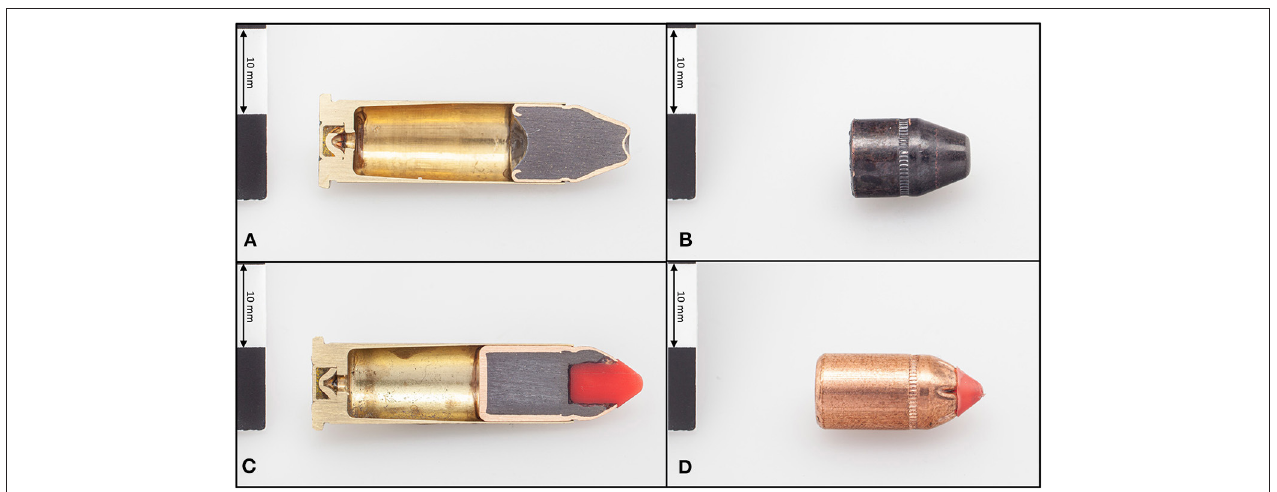
FIGURE 2 | Specimens of a full metal jacket .38 SPL FMJ-TC cartridge (A) and projectile (B) with a truncated cone and a .357 MAG FTX ® cartridge (C) and projectile (D) with the special tip, with the cartridges cut open in the center to illustrate the